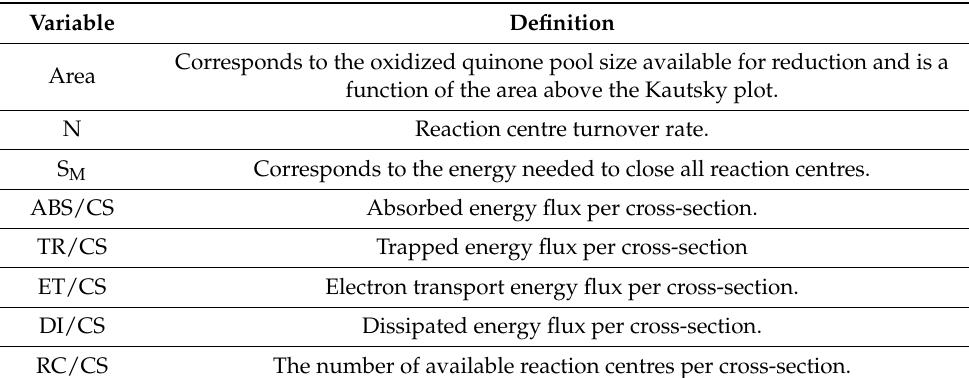
Table 1. Summary of the fluorometric analysis parameters and their